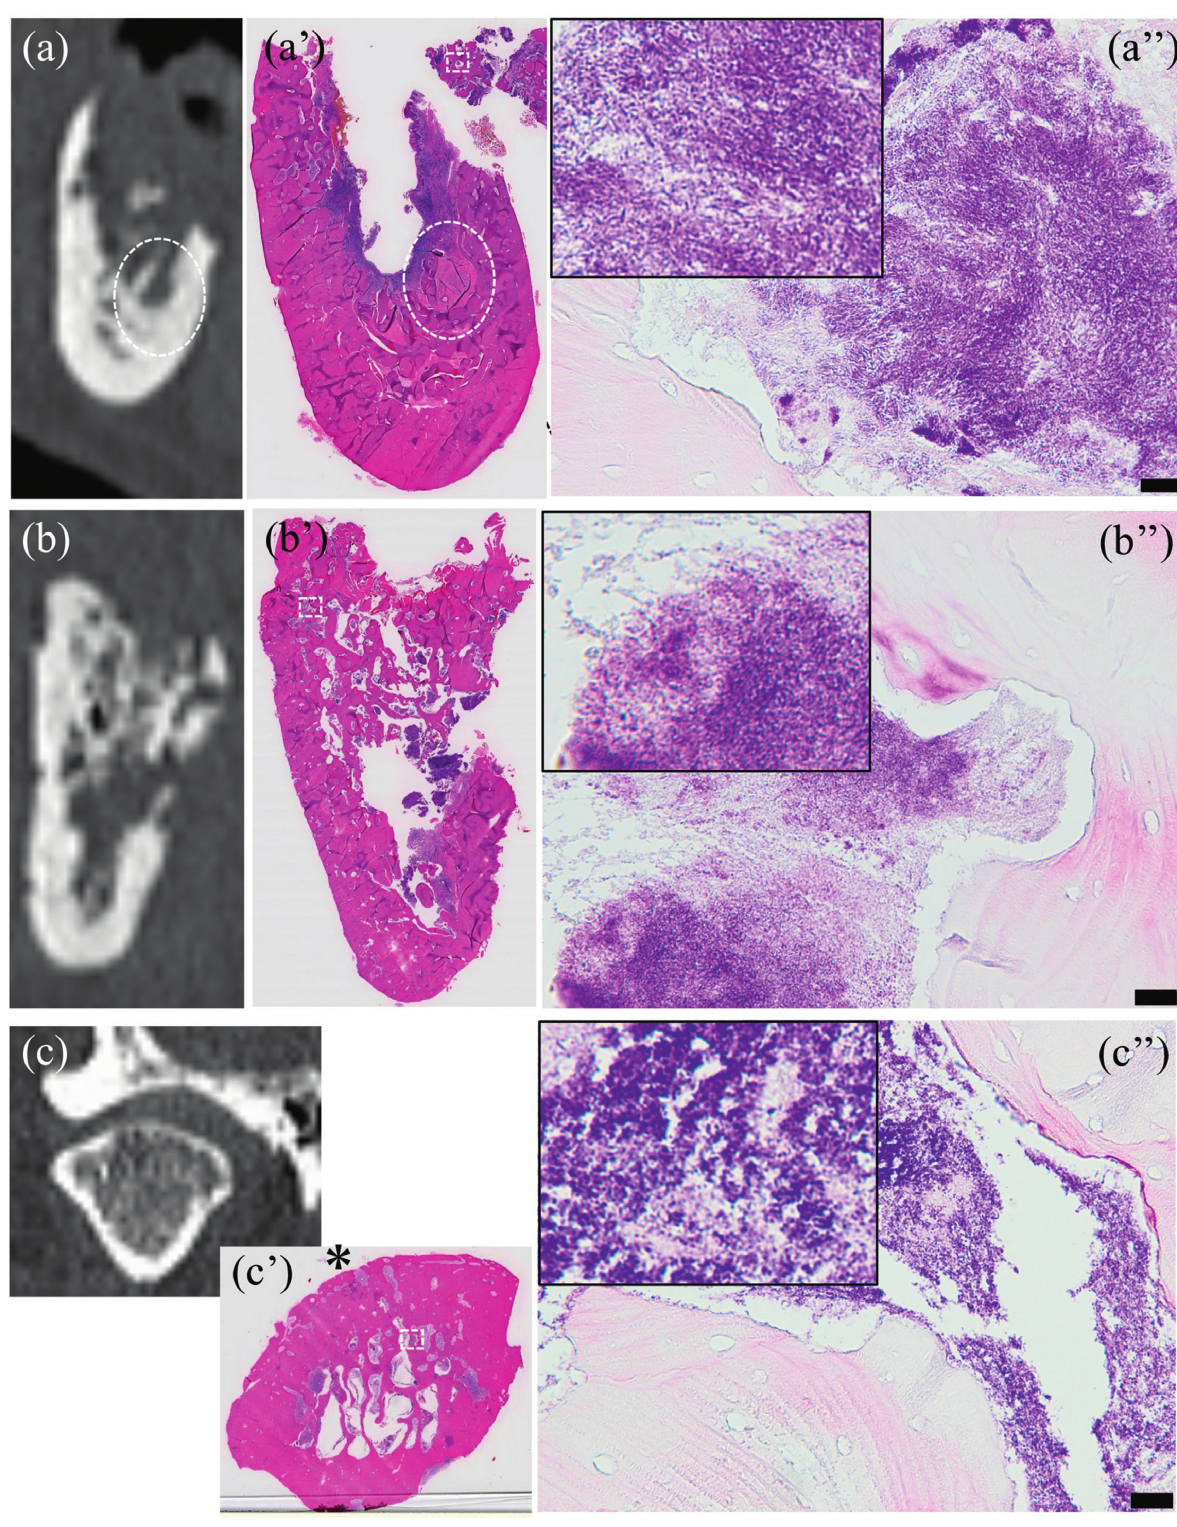
Figure 2: Preoperative CTimages (a–c) and results of hematoxylin and eosin staining (a’–c’) in patient 3. White dotted circle in (a) and (a’) indicate mandibular canal. Results of Gram staining of areas indicated with white dotted boxes are shown in enlarged images (a”–c”). Severe bone destruction and inflammation in mandibular body (a’) and ramus (b’). Apparent bacterial colonization is evident (a” and b”). Bone marrow hollowing and inflammatory cell infiltration (c’), as well as bacterial colonization (c”), are evident in mandibular condyle. Asterisk ( ∗ ) indicates the articular surfaces of condyle. Scale bar � 20 μ